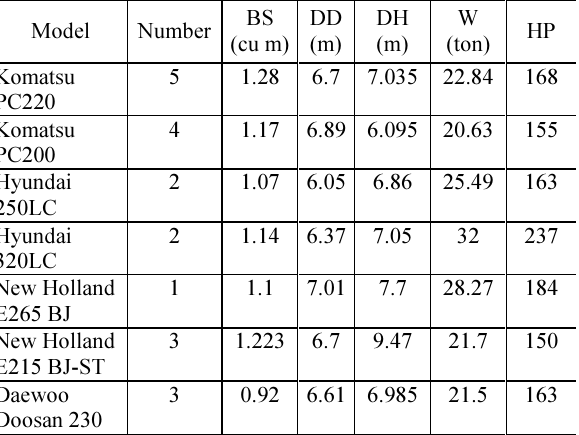
Table 10. Backhoe shovels used in the